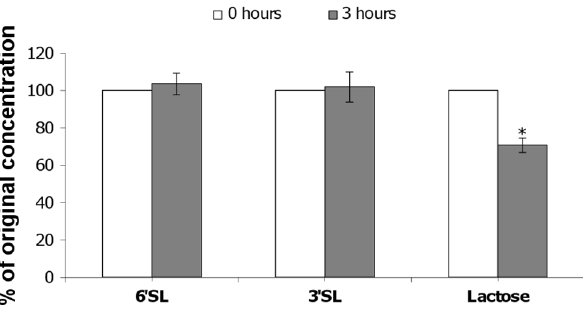
Figure 2. Bacterial influence on oligosaccharide concentrations during exposure. Aliquots of media prior to and following exposure with B. longum subsp. infantis ATCC 15697 for 3 hours were assessed by HPLC. Abbreviations: 6 9 SL - 6 9 Sialyllactose; 3 9 SL - 3 9 sialyllactose. Results are expressed as percentage of initial oligosaccharide concentration in non-exposed media for each treatment group with error bars representing standard deviation. *denotes p , 0.005.